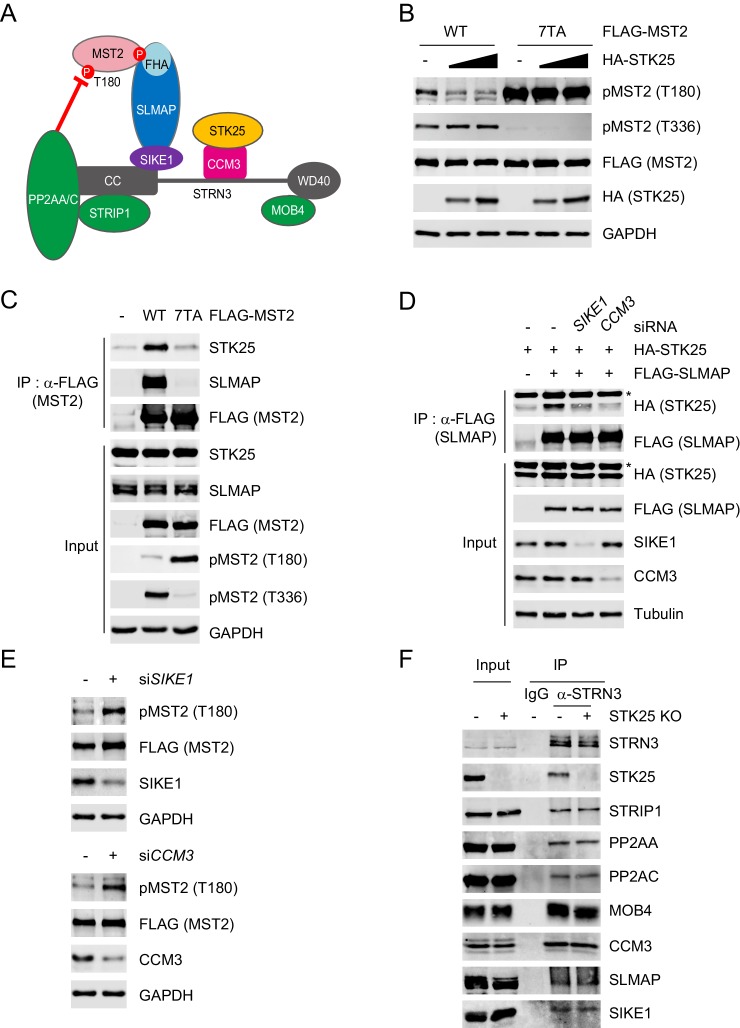
STK25 inactivates MST2 as a component of STRIPAKSLMAP.(A) Model for STRIPAKSLMAP-mediated MST2 inactivation. (B) 293FT cells were co-transfected with HA-STK25 and the indicated FLAG-MST2 plasmids. The total cell lysates were blotted with the indicated antibodies. (C) 293FT cells were transfected with the indicated FLAG-MST2 plasmids. The total cell lysates (input) and anti-FLAG immunoprecipitation (IP) were blotted with the indicated antibodies. Anti-GAPDH blot was used as the loading control. (D) 293FT cells were co-transfected with the indicated siRNA and plasmids. The total cell lysates (input) and anti-FLAG IP were blotted with the indicated antibodies. Anti-Tubulin blot was used as the loading control. Asterisk denotes a non-specific band. (E) Immunoblots of 293FT cell lysates co-transfected with the indicated siRNAs and FLAG-MST2. (F) The total cell lysates (input) and anti-IgG or anti-STRN3 IP of control 293A cells and STK25 KO 293A cells were blotted with the indicated antibodies.